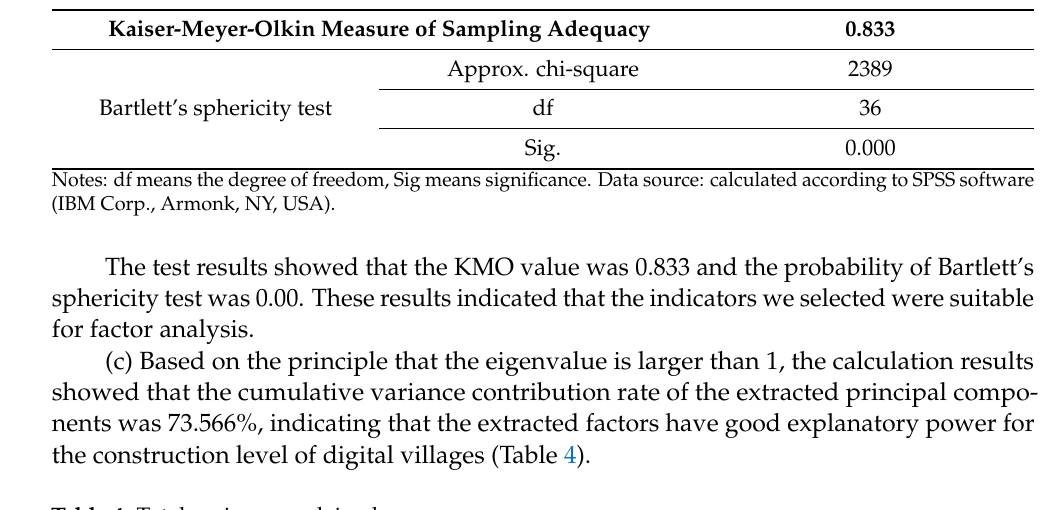
Table 4. Total variance